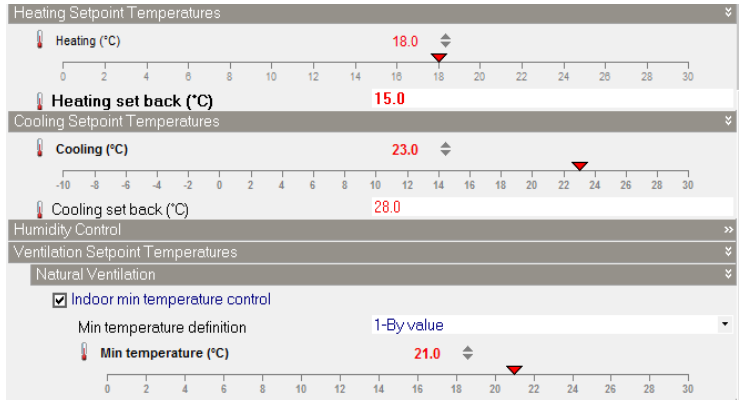
Fig. 5. Set point temperature controls in activity tab in Design Builder